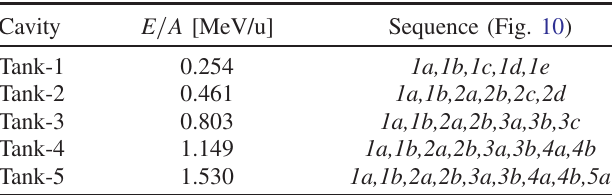
TABLE III. Tune sequences for the ISAC-DTL autofocus, specifying the devices that are to be optimized by TRANSOPTR . The sequences are shown in Fig. 10 and allow for the rapid computation of the ISAC-DTL optics at any E=A .